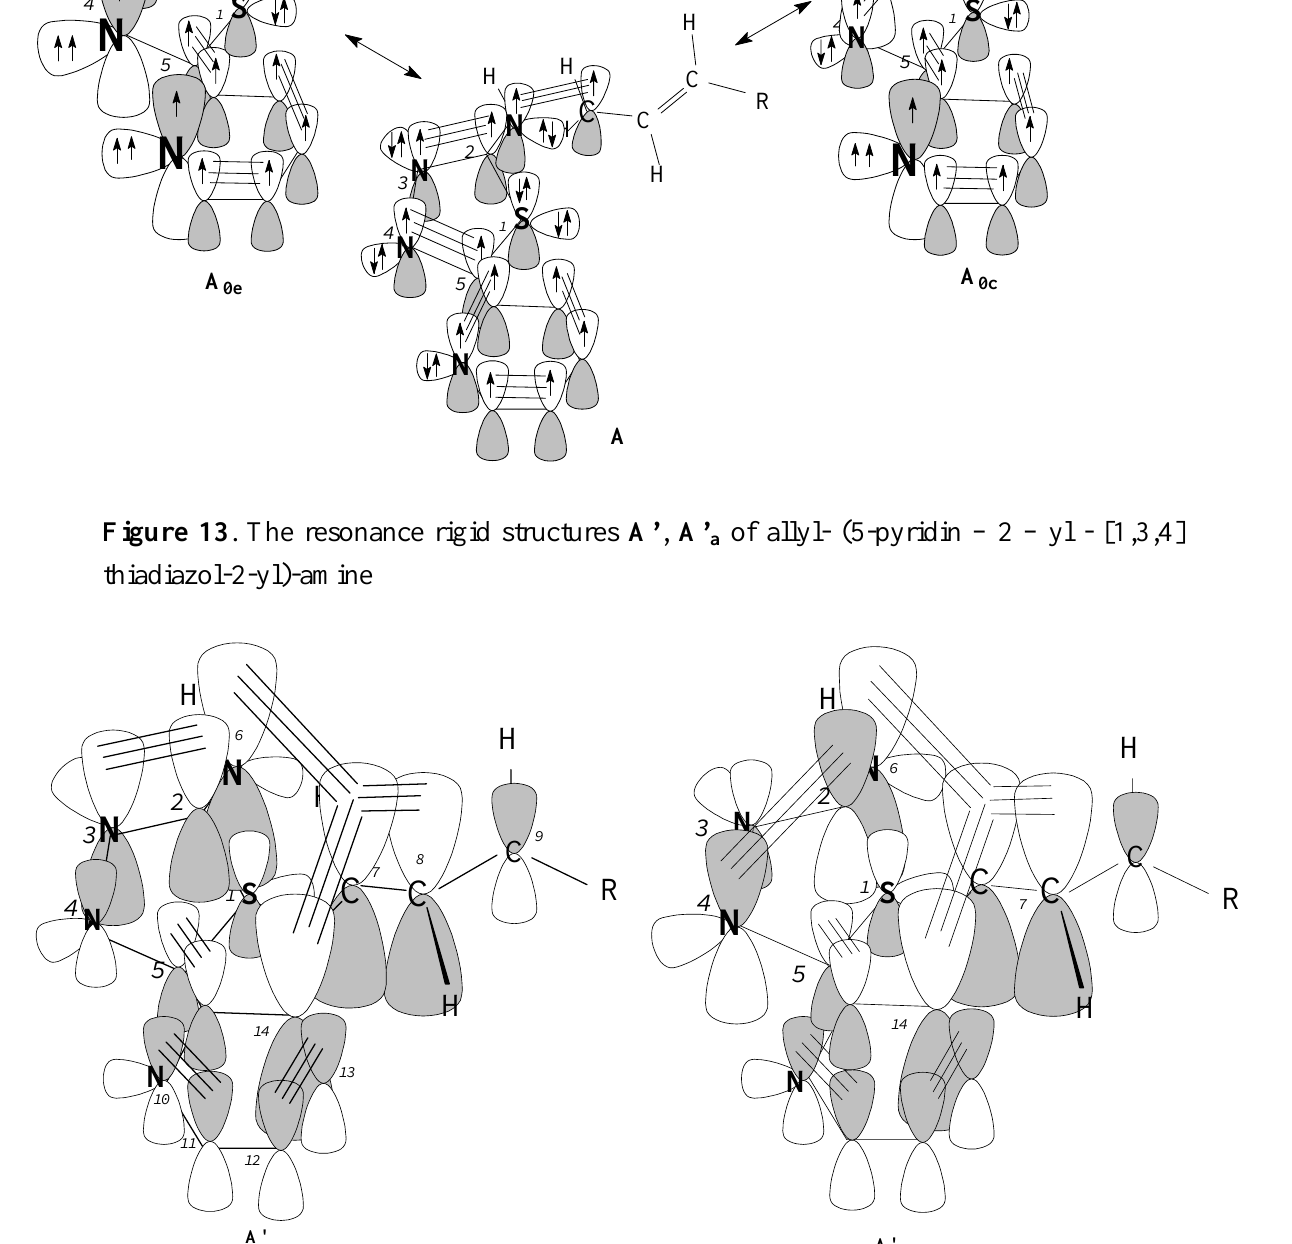
Figure 12 . The changes of the electron configuration of N3 N10 and N4 N10 nitrogen atoms of allyl- (5-pyridin – 2 – yl - [1,3,4] thiadiazol-2-yl)-amine, the structures A